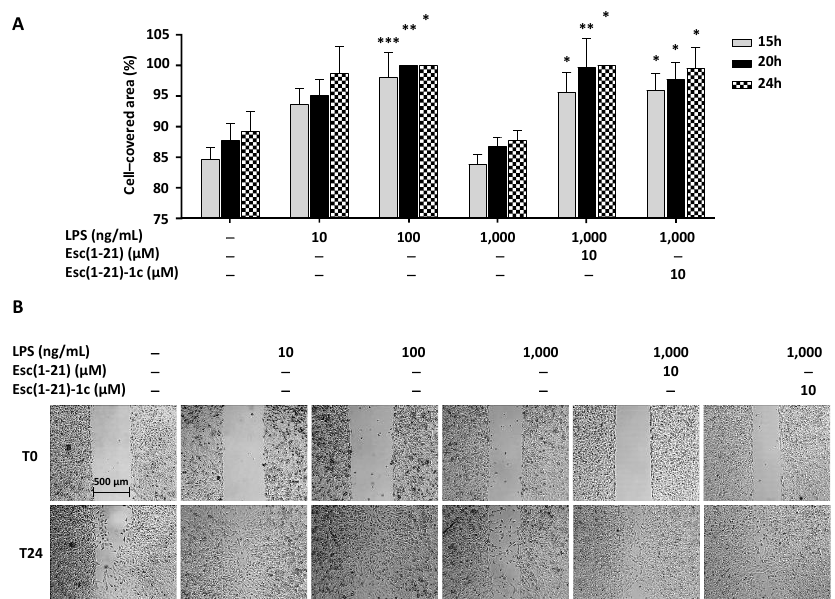
Figure 4. ( A ) Effect of LPS alone or LPS in combination with Esc(1-21) and its diastereomer Esc(1-21)-1c on the closure of a pseudowound field produced in a monolayer of A549 cells. A549 cells were seeded in each side of an Ibidi culture insert. After reaching confluence, they were treated or not with the LPS or the LPS plus peptide, as indicated. Cells were photographed at the time of insert removal (T0) and checked for cell migration after 15, 20, and 24 h. The percentage of the cell-covered area at each time point is indicated on the y -axis. Control (Ctrl) represents cells not treated with the peptide or the LPS. All data are the mean of three independent experiments ± SEM. The level of statistical significance between Ctrl and LPS-treated samples or between samples treated with 1000 ng/mL LPS and LPS plus peptide was determined by two-way ANOVA analysis and is indicated as follows: * p < 0.05; ** p < 0.01 and *** p < 0.001. ( B ) The micrographs show representative results of pseudowound closure induced after 24 h of the LPS treatment with respect to that of Ctrl sample or the LPS in the presence of peptides with respect to that of LPS-treated